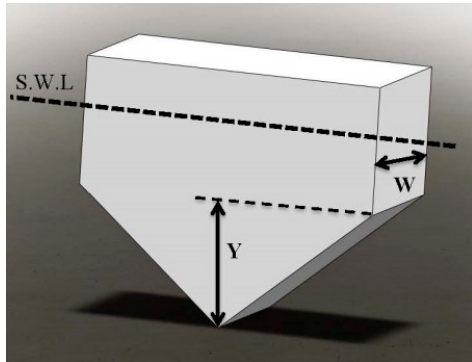
Figure 12. Description of the bottom chamfered shape.